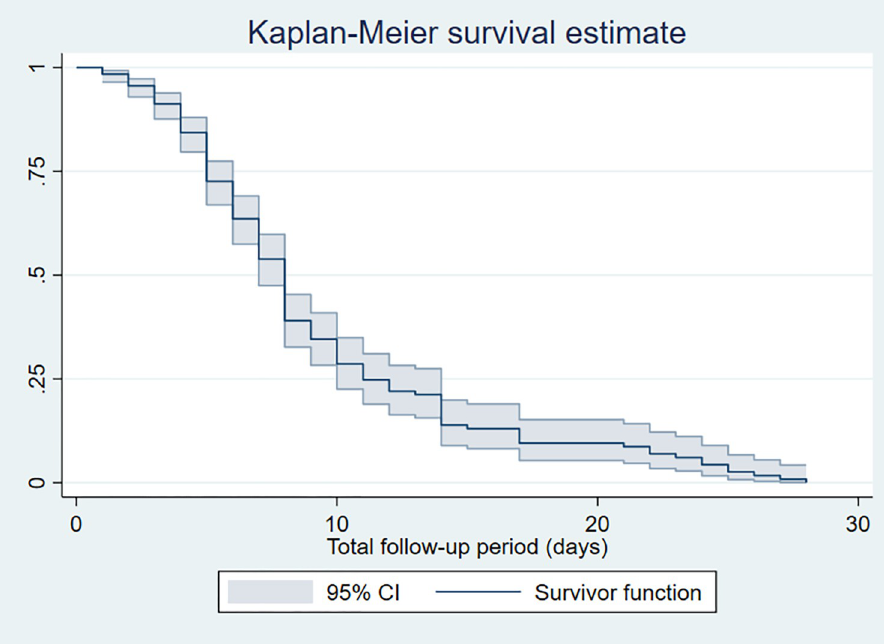
Fig 4. Kaplan-Meier survival estimate of asphyxiated newborns admitted to the NICU of DCSH, Amhara region, Northeast Ethiopia (N = 378).